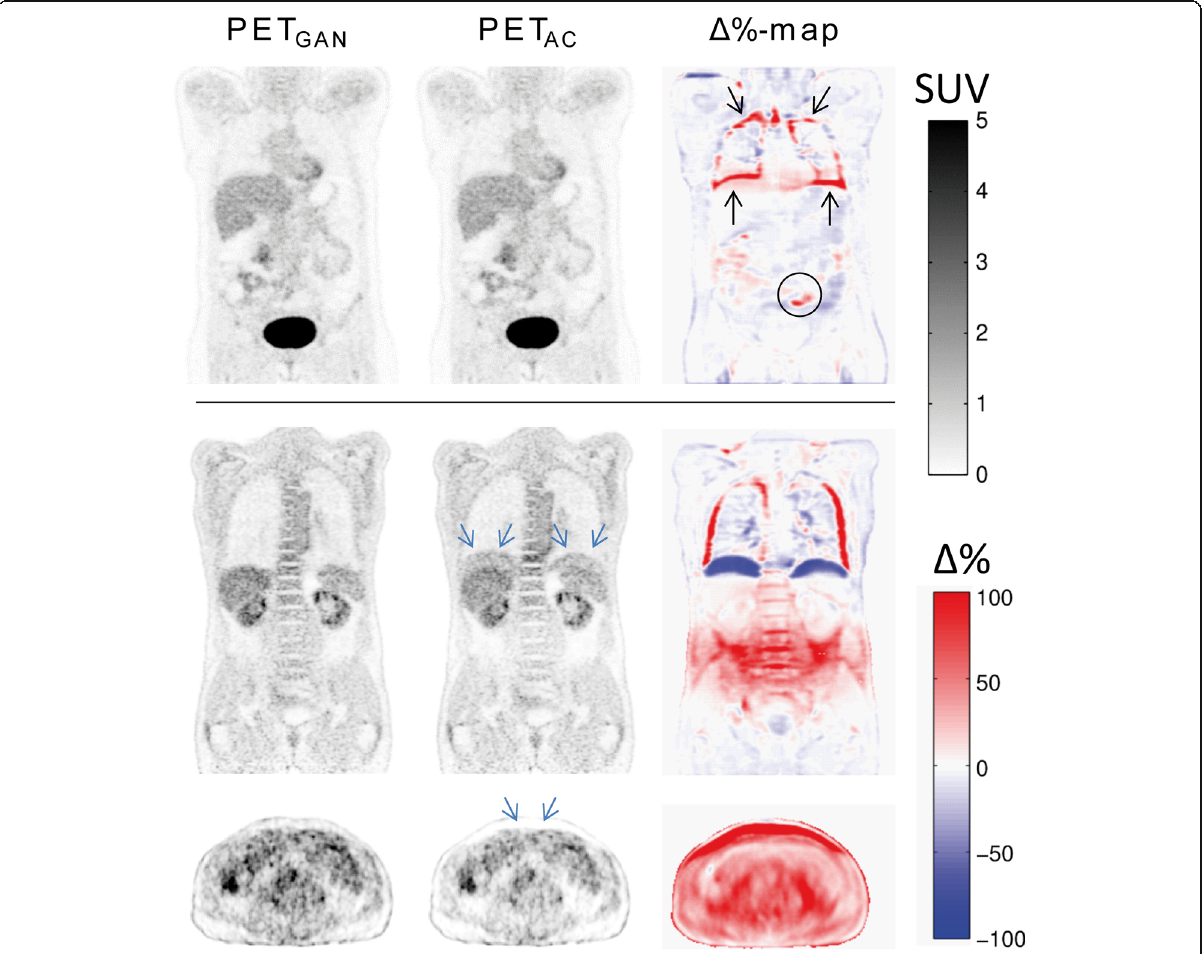
Fig. 3 Two example data sets of PET data reconstructed with the generated pseudo CT (PET GAN , left), reconstructed using the acquired CT (PET AC , middle) and their voxel-wise percent difference map ( Δ %-map, right). The top example shows typical results with no visually appreciable differences between PET GAN and PET AC in most anatomic regions and with more pronounced deviations localized along the lung border (black arrows) and in areas of air-filled bowel (black circle). The bottom example depicts a so-called banana artifact in PET AC due to acquisition of PET and CT in different respiratory states resulting in relative overestimation of SUVs along the diaphragm and relative underesitmation of SUVs in the abdomen (blue arrows). These artifacts were not present on PET GAN